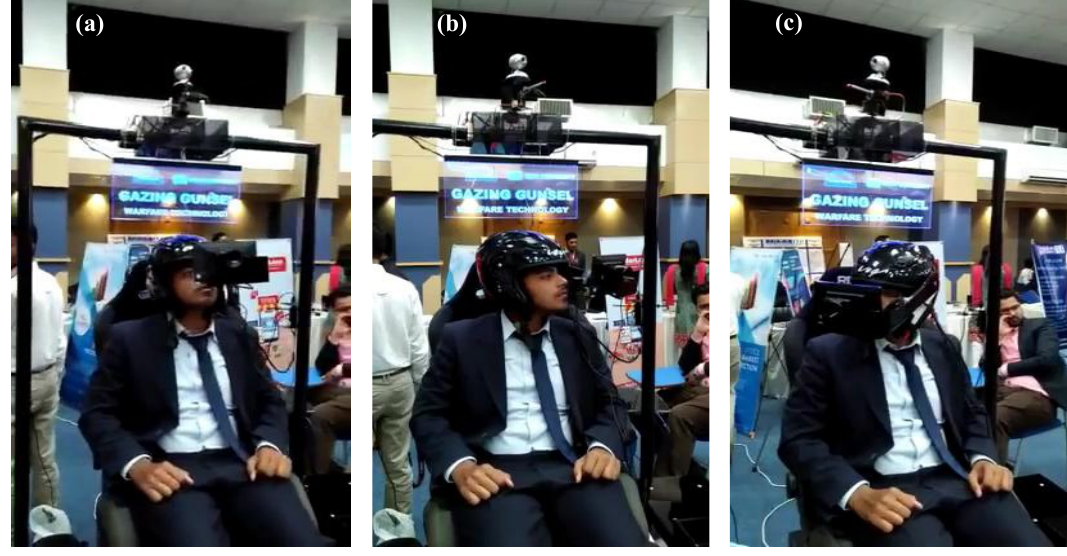
Figure 8. Results of laser movement with respect to head